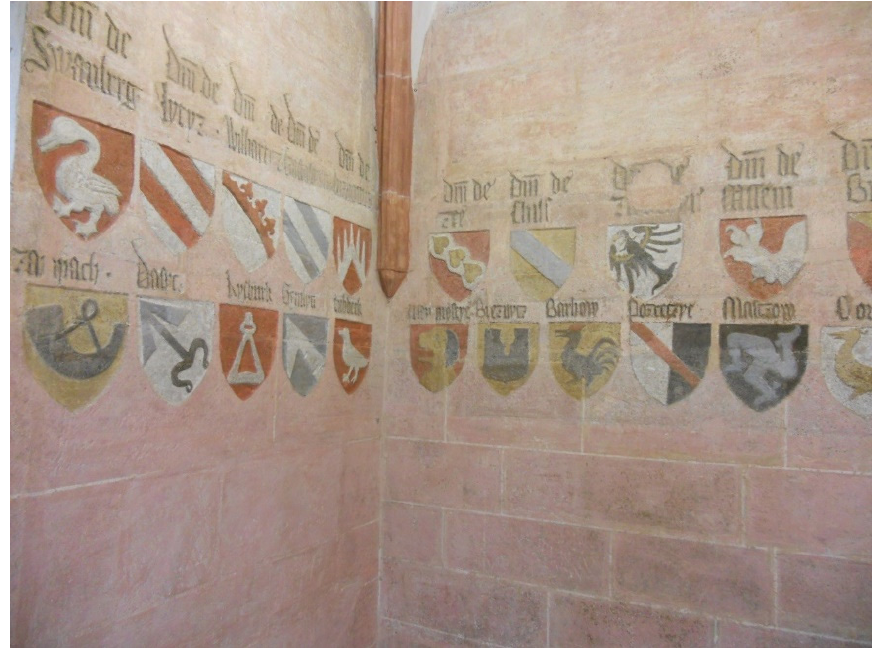
Figure 11. Coats of arms on Lauf Castle.